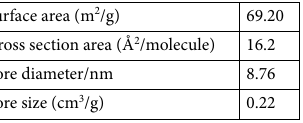
Table 2. Physicochemical properties of CoZnAl 2 O 4 catalyst.